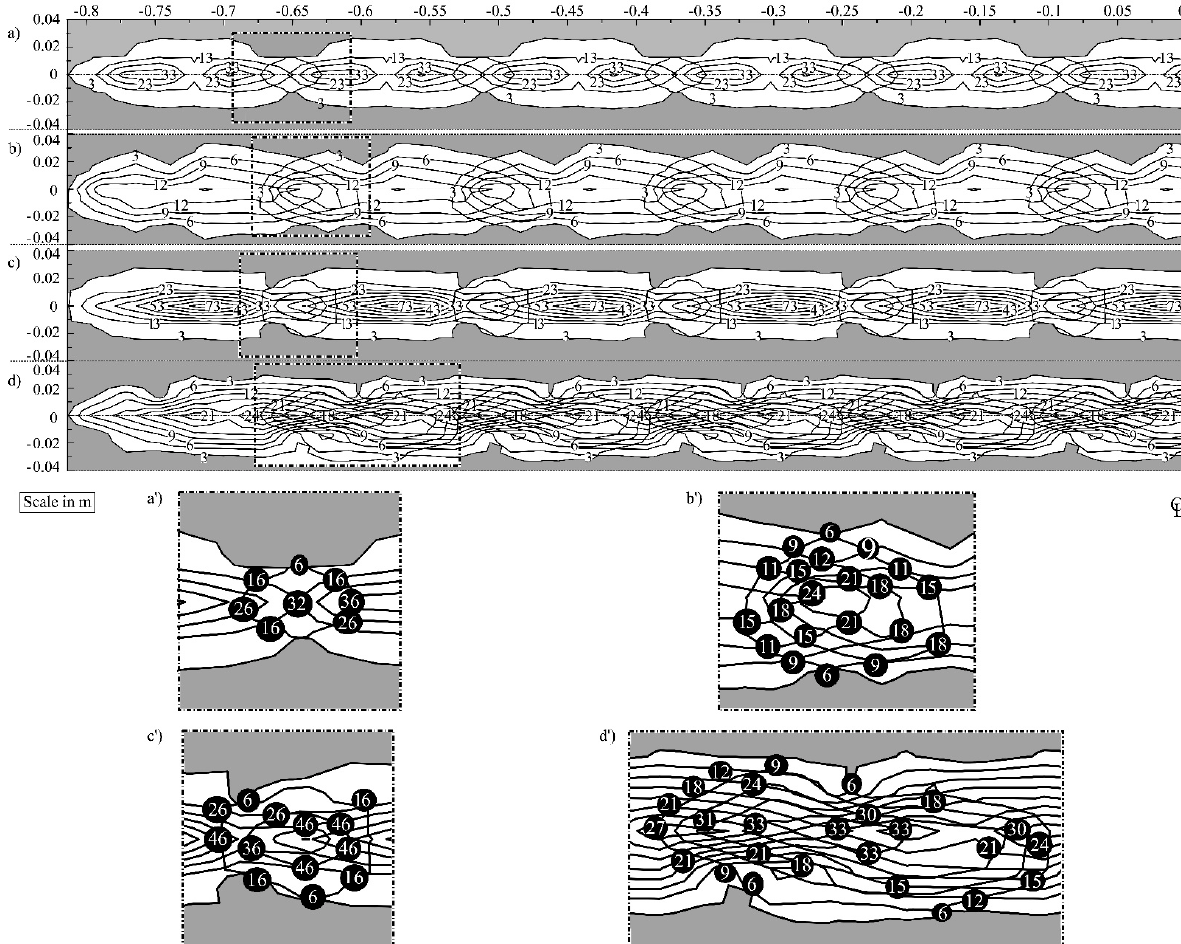
Figure 4. Impingement density map distribution on the wide face of the continuous casting slab for the Lechler 632.644 nozzle. ( a ) and ( b ) pressure of 137.9 kPa with 0.15 m and 0.25 m, respectively. ( c ) and ( d ) pressure of 301.6 kPa with 0.15 m and 0.25 m, respectively. the Lechler 632.644 nozzle. ( a , b ) pressure of 137.9 kPa with 0.15 m and 0.25 m, respectively. ( c , d ) pressure of 301.6 kPa with 0.15 m and 0.25 m,